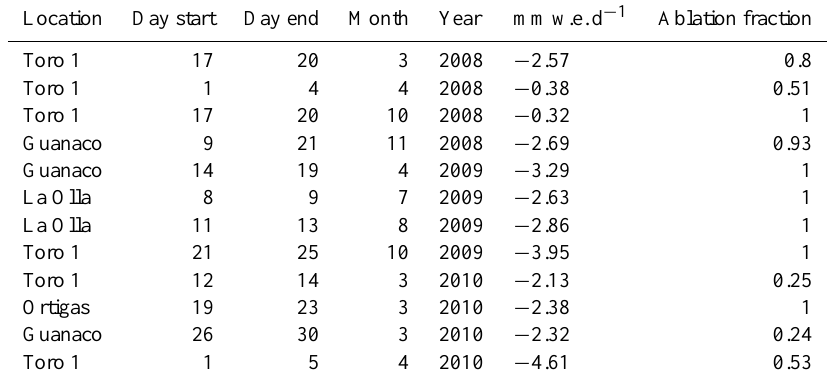
Table 3. Lysimeter experiments summary (water equivalent) giving the sublimation rate in mmw.e.d − 1 and as a fraction of the ablation rate Location